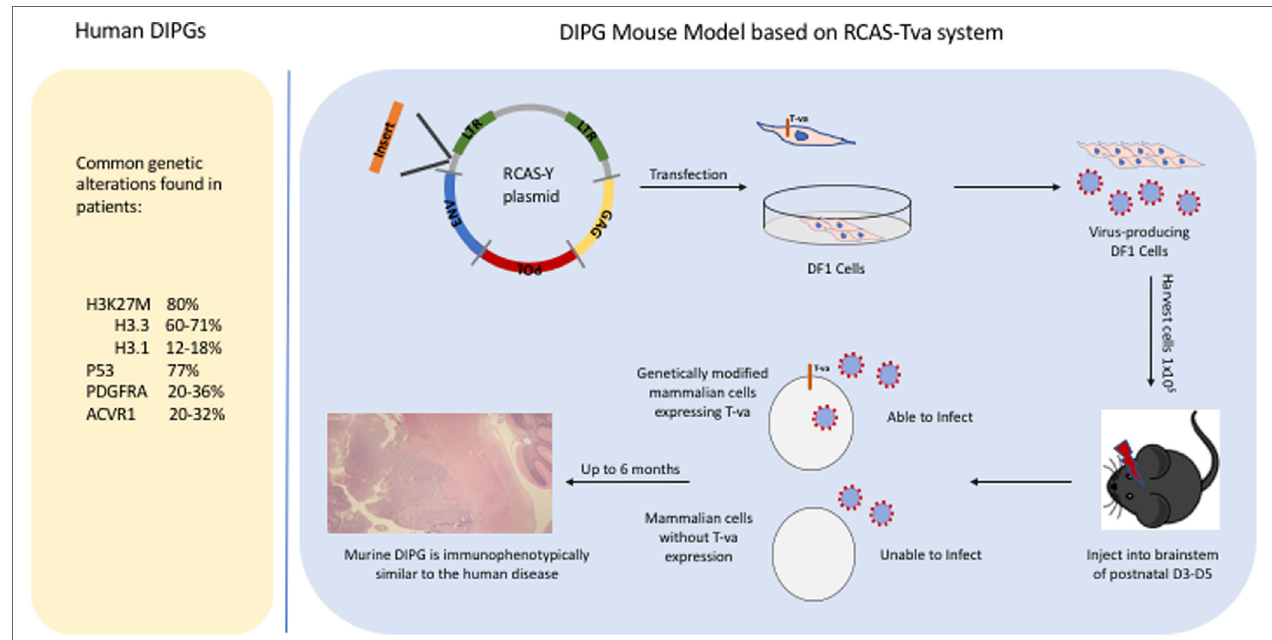
FiGURe 1 | Common genetic alterations in human diffuse intrinsic pontine gliomas (DIPGs) and a schematic illustrating how the RCAS/tumor virus A (TVA) system is used to induce murine DIPGs.